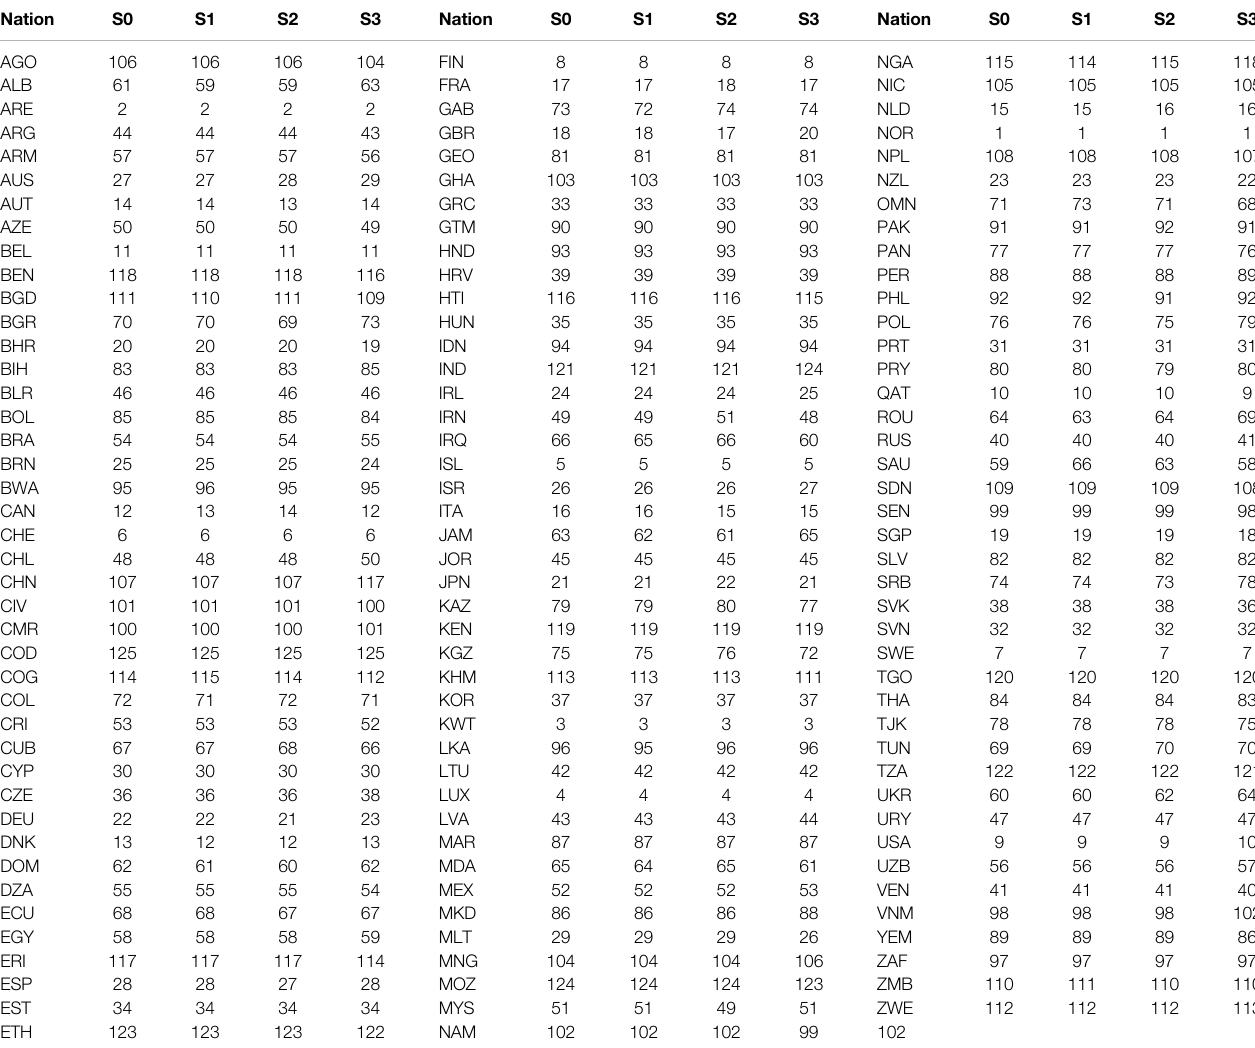
TABLE 2 | Sensitivity of national ranks in 2001 in weights of indicators.